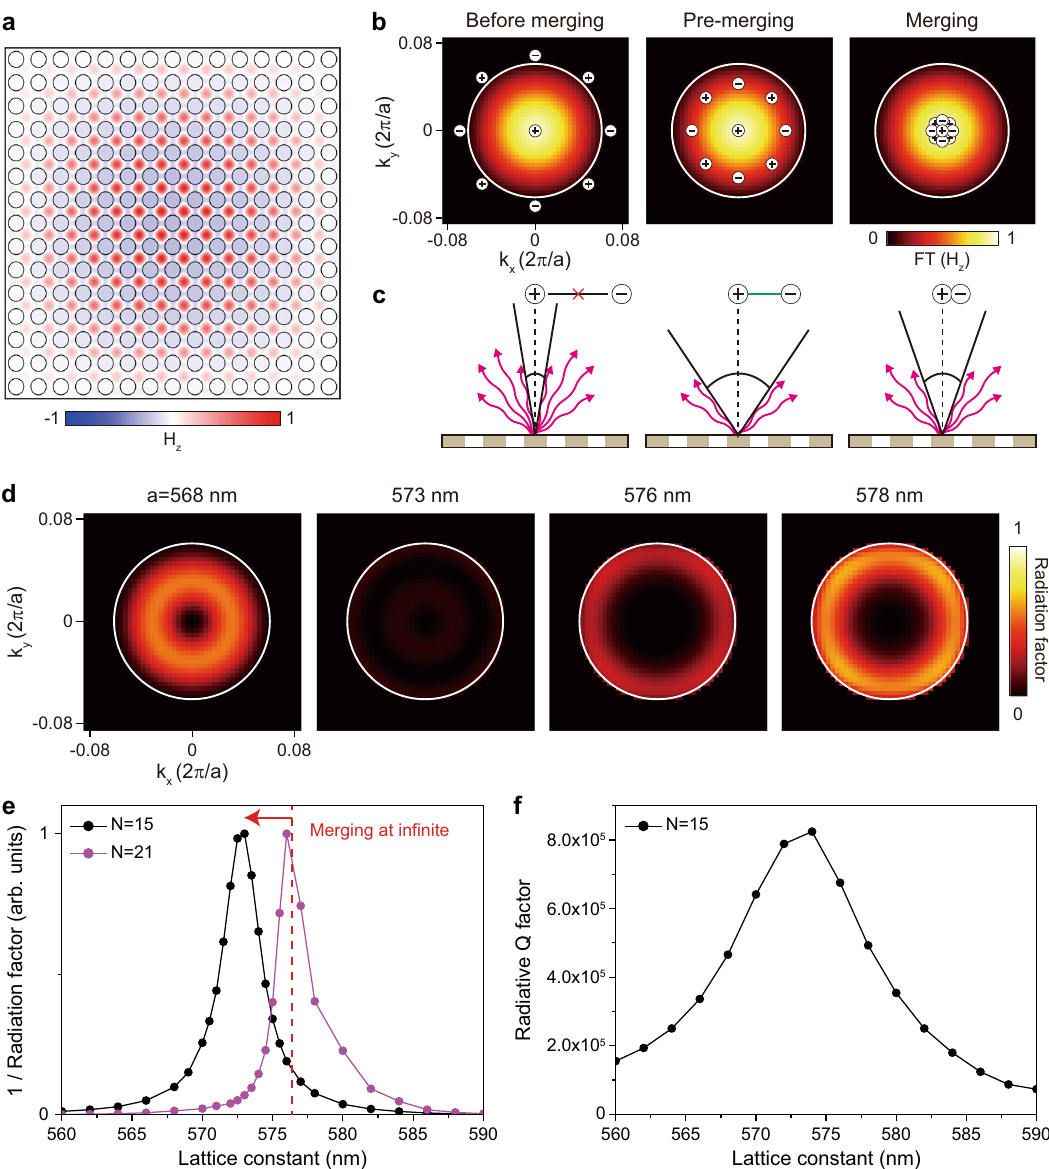
Fig. 2 Merging of BICs in the fi nite-size structure. a Calculated H z fi eld distribution at a = 573 nm in the fi nite-size domain with N = 15. N is the number of air holes along the vertical (or horizontal) direction. b Topological charge distributions in FT(H z ) at before-merging (left), pre-merging (middle), and merging (right). FT denotes the spatial Fourier transformation. The white circle of 7° indicates the fi rst fi eld minimum. c Schematic illustrations of the radiative loss in the three cases corresponding to b . d Calculated radiation factor, de fi ned as |FT(H z )/Q | , for a = 568, 573, 576, and 578 nm. The largest dark area is obtained at pre-merging of a = 573 nm. e The values of the inverse radiation factor plotted as a function of the lattice constant for N = 15 (black) and N = 21 (purple). The vertical red dashed line indicates the merging point in the in fi nite-size domain. f Radiative Q factor for N = 15 as a function of the lattice constant, calculated by the FDTD